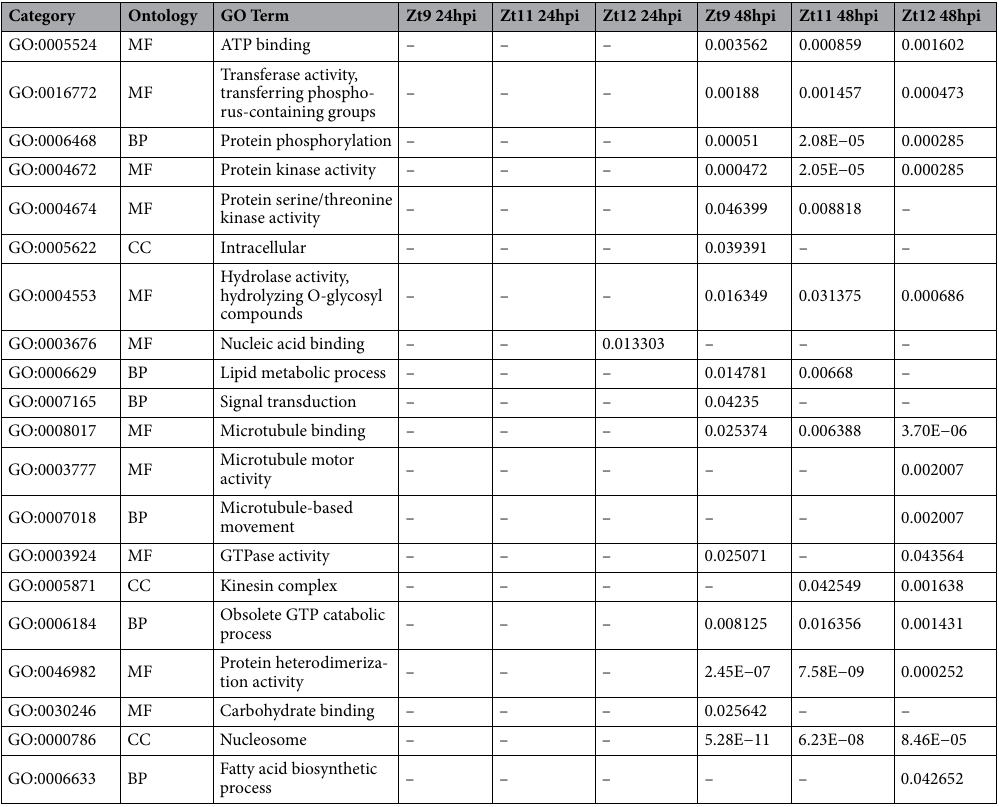
Table 5. Top 20 GO terms enriched among SSP treatments in downregulated DEGs and their BH-FDR adjusted P -values.